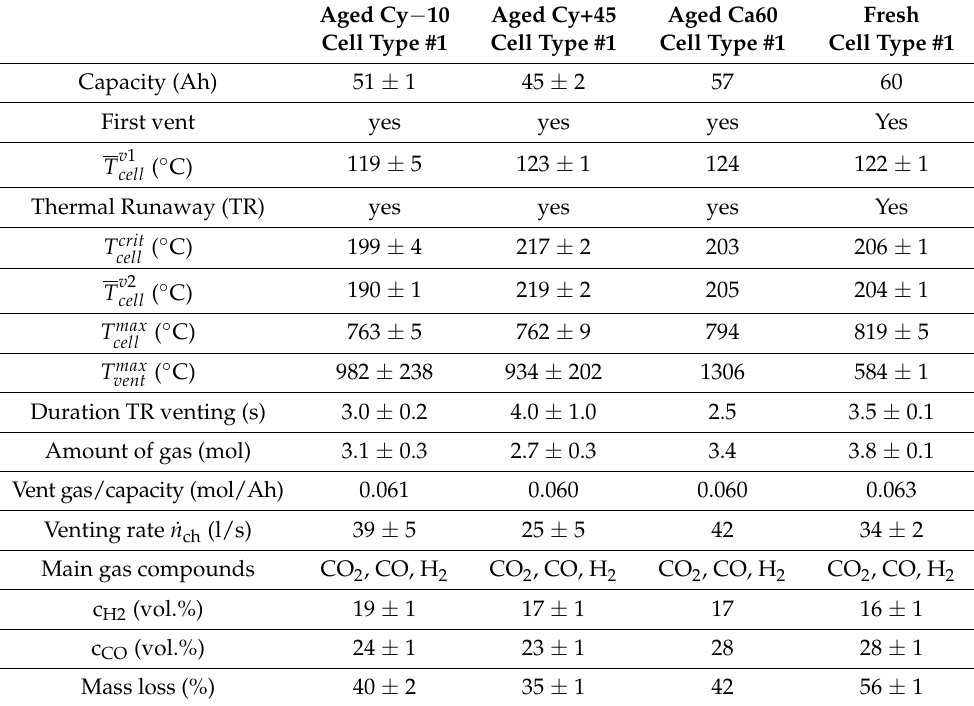
Table 4. Summary of safety relevant parameters of differently aged automotive type #1 cells using overtemperature trigger in comparison to the results of fresh